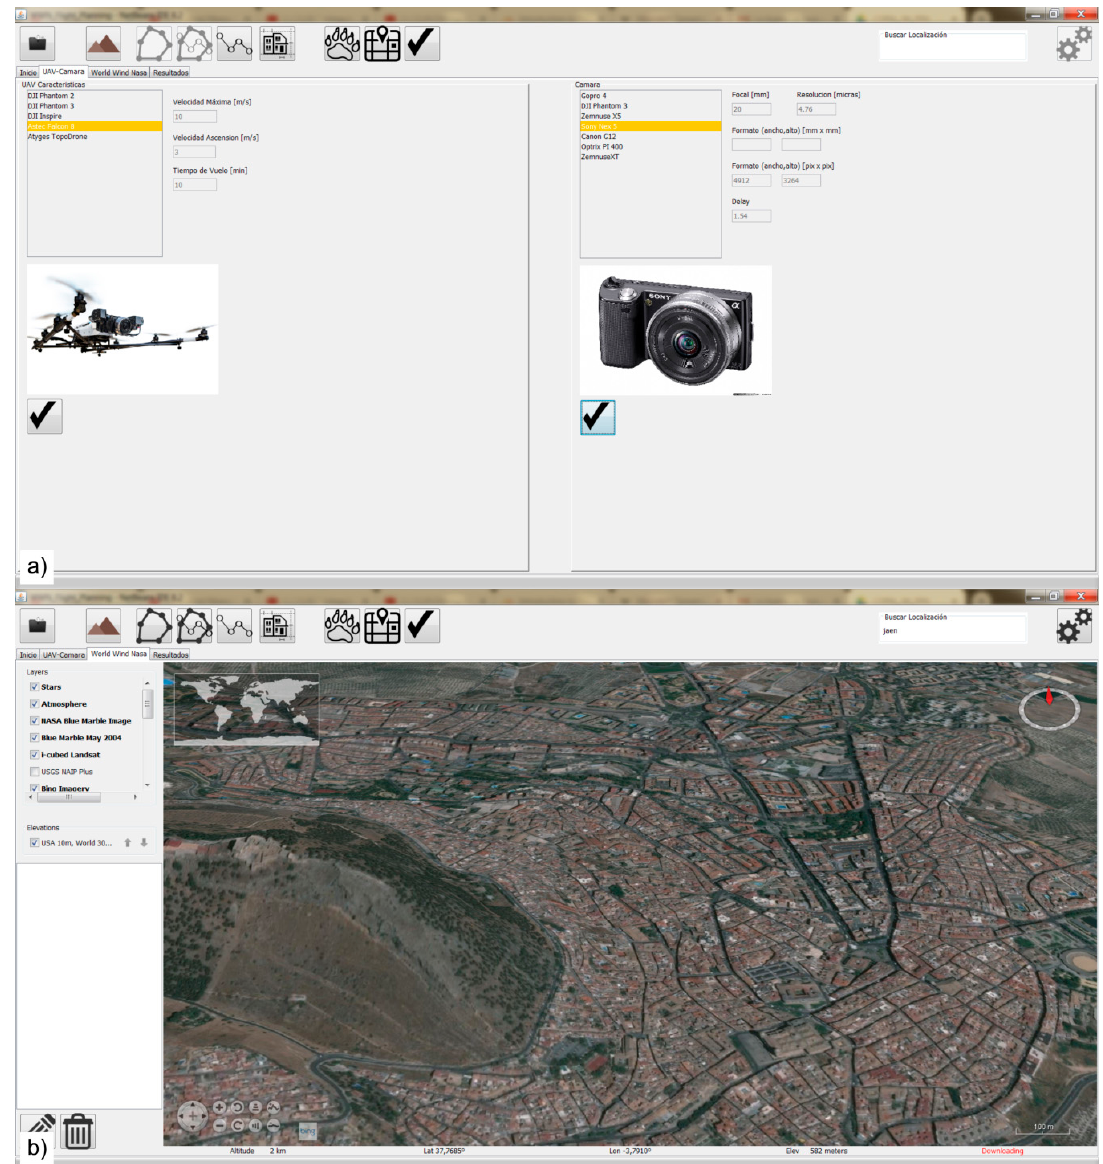
Figure 4. MFPlanner3D user’s interface: ( a ) project definition module and ( b ) flight planning module.